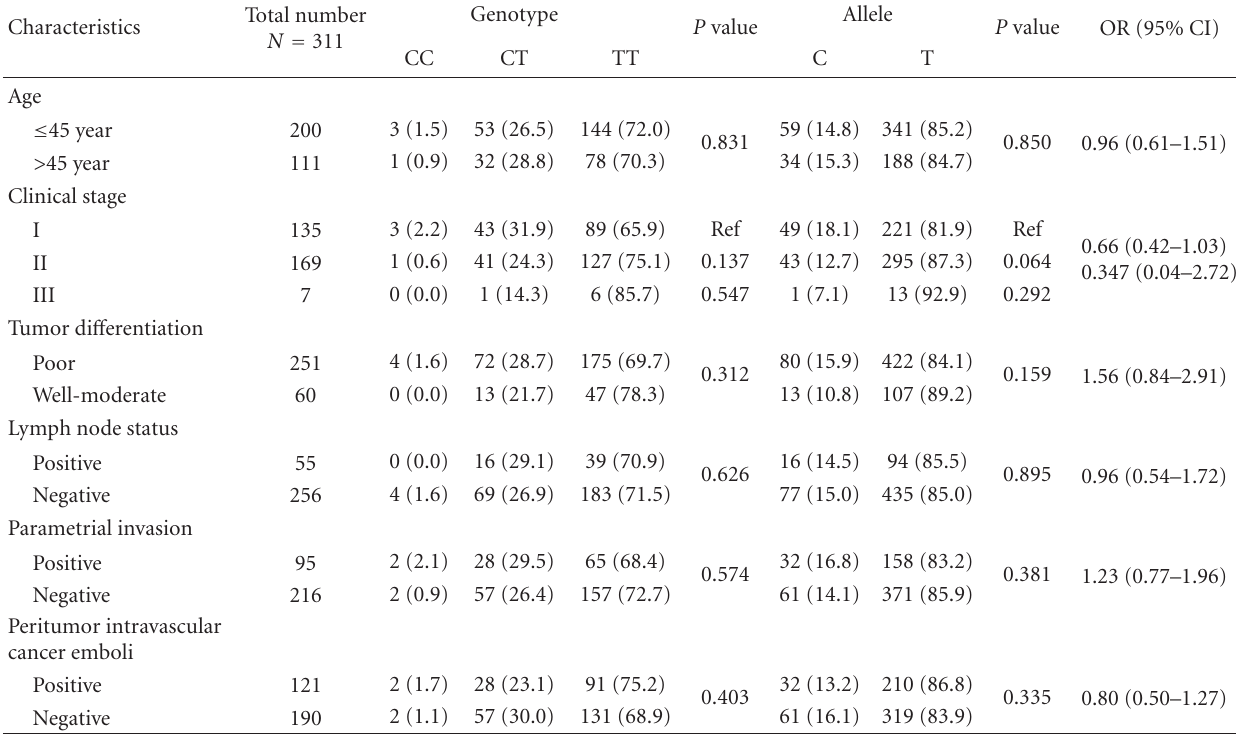
Table 3: Association between the allele frequency and genotype distribution of rs763780 polymorphism and patient’s characteristics.